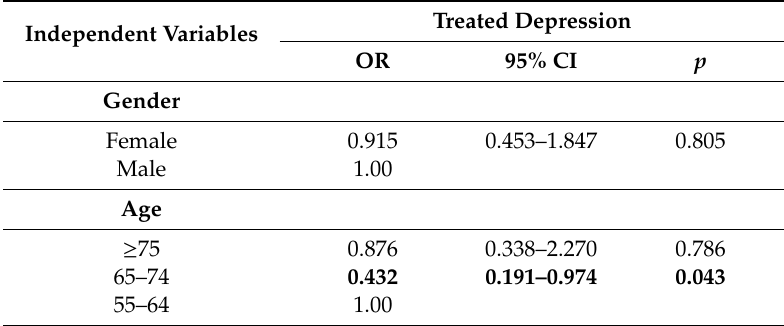
Table 3. Logistic regression on distinction of untreated and treated depression among individuals with depression ( n =